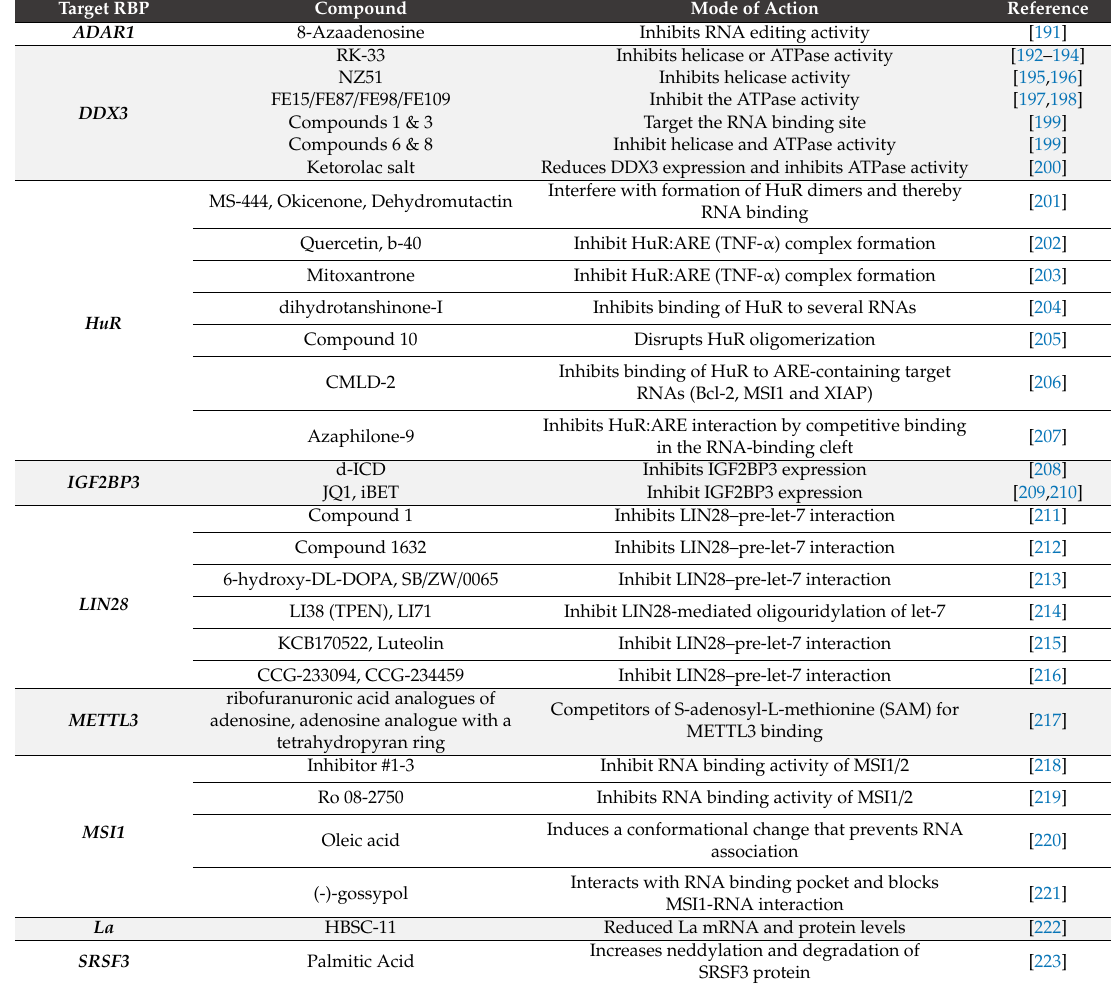
Table 2. Inhibitors of RBPs involved in oral cancer